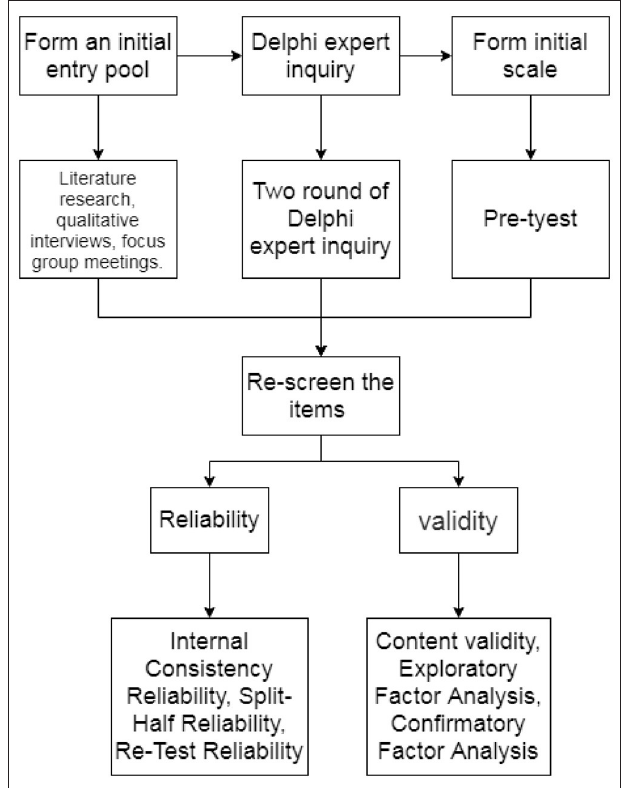
FIGURE 1 | The study